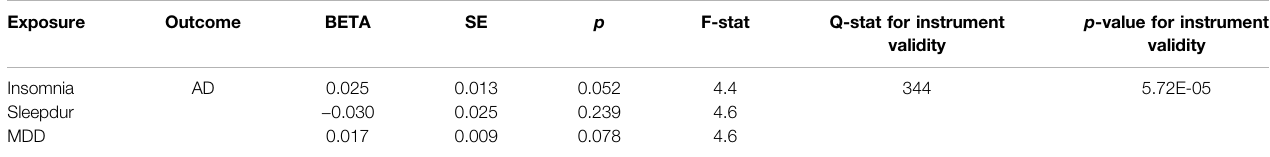
p -value for instrument validity validity